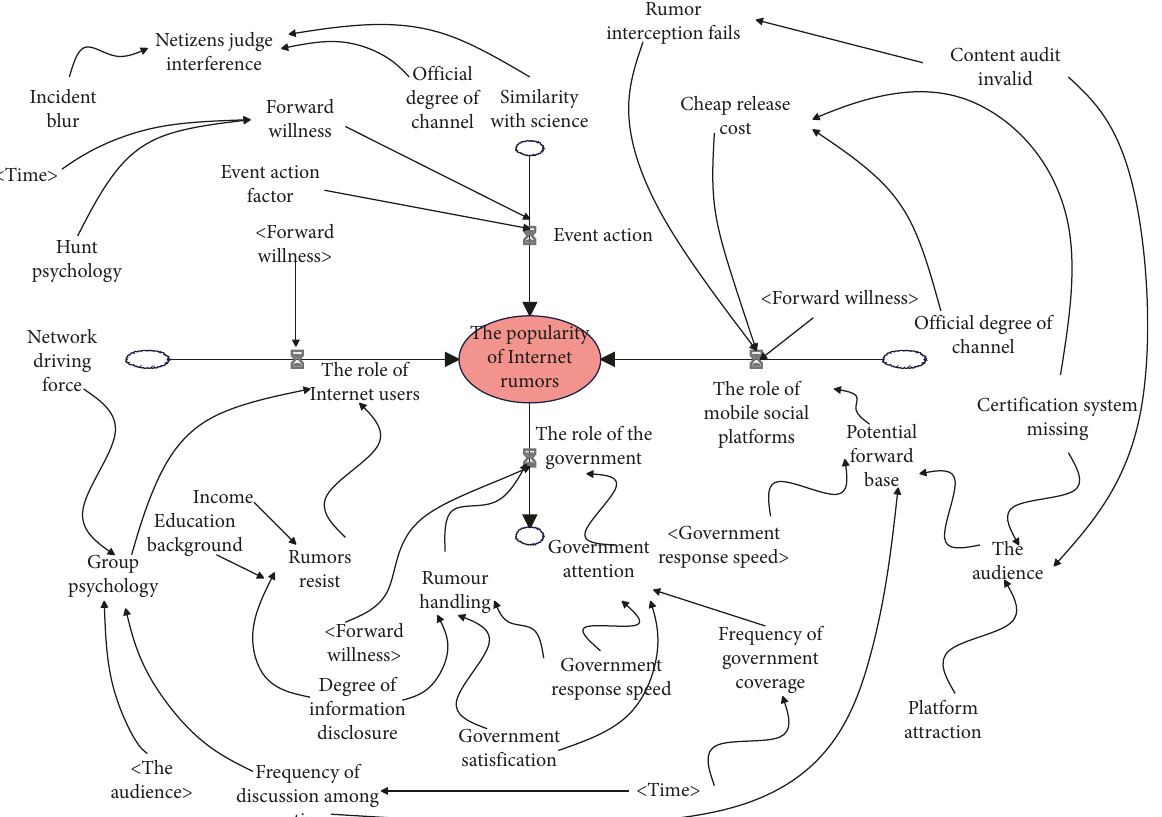
Figure 7: A flow diagram of the rumor-spreading system in the mobile social